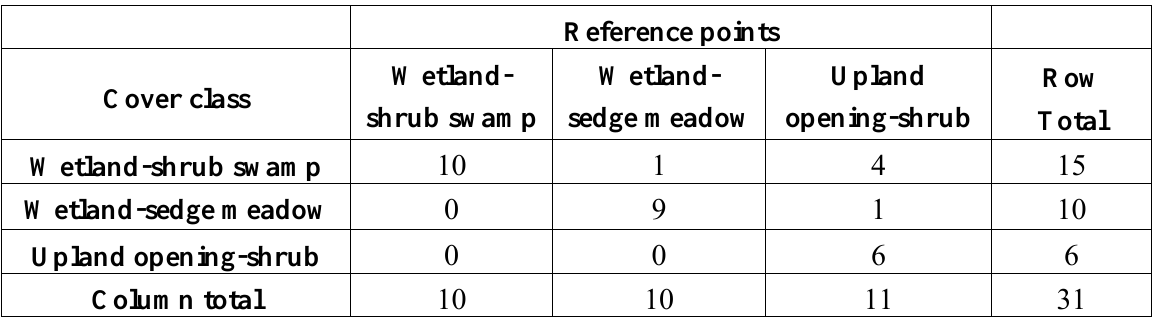
Table 4A. Another sample of classification results of the corrected image (image 1) for Nicolet vegetation cover.